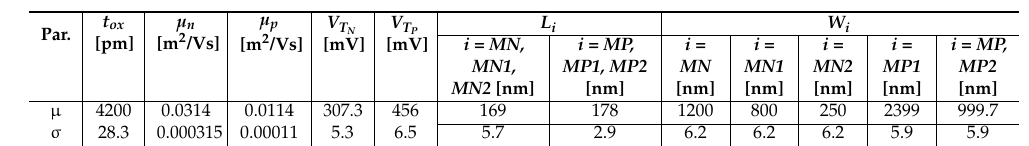
Table 2. Model parameters.